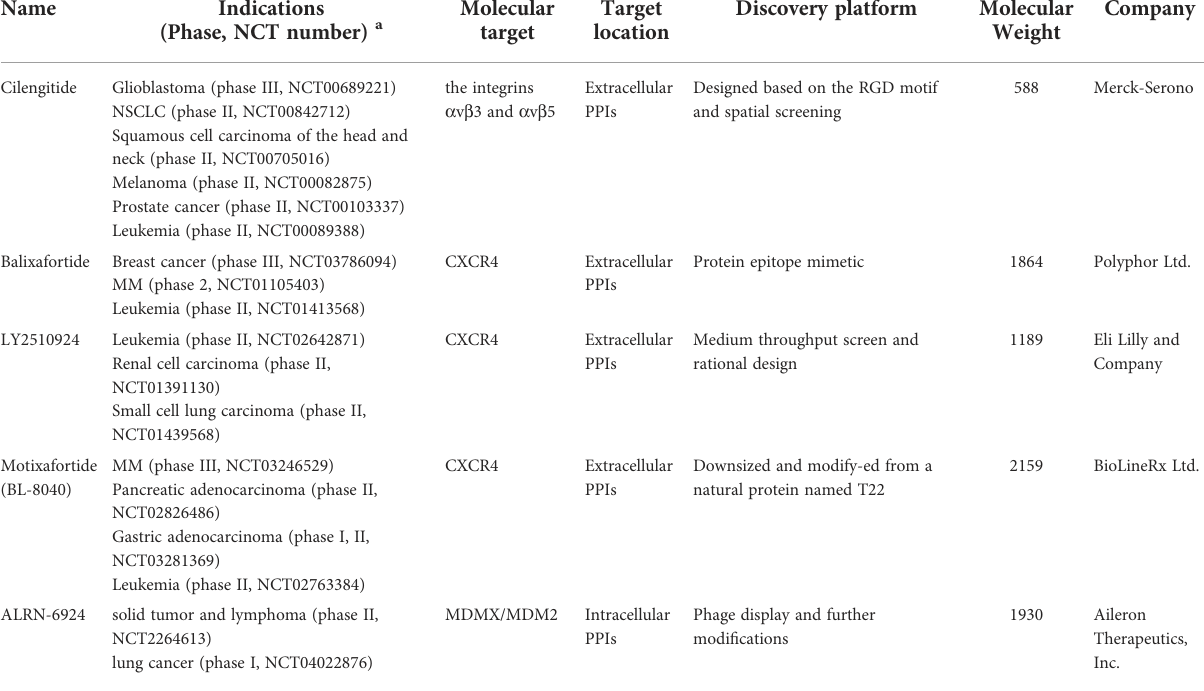
TABLE 1 Details of oncology macrocyclic peptide drugs in clinical